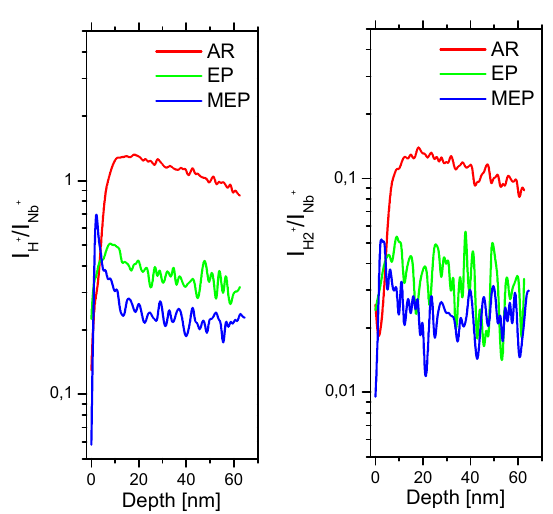
Figure 15. Dependence of rates of hydrogen positive secondary ions (H + and H 2+ ) currents to the secondary niobium ion currents on the depth of ion etching. Separated results for H + and H 2+ ions are displayed.